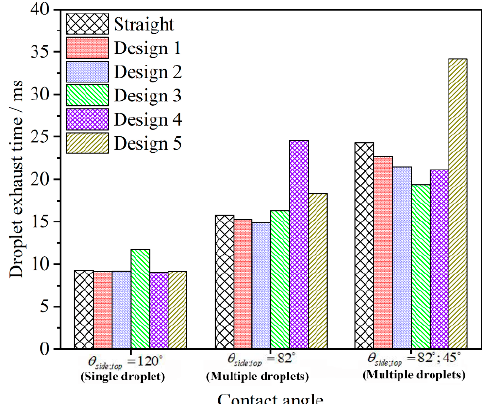
Figure 5. Histogram plot of droplet exhaust time for different wall contact angles at the same inlet velocity and GDL contact angle (12.5 ms − 1 and θ GDL = 120°, respectively).